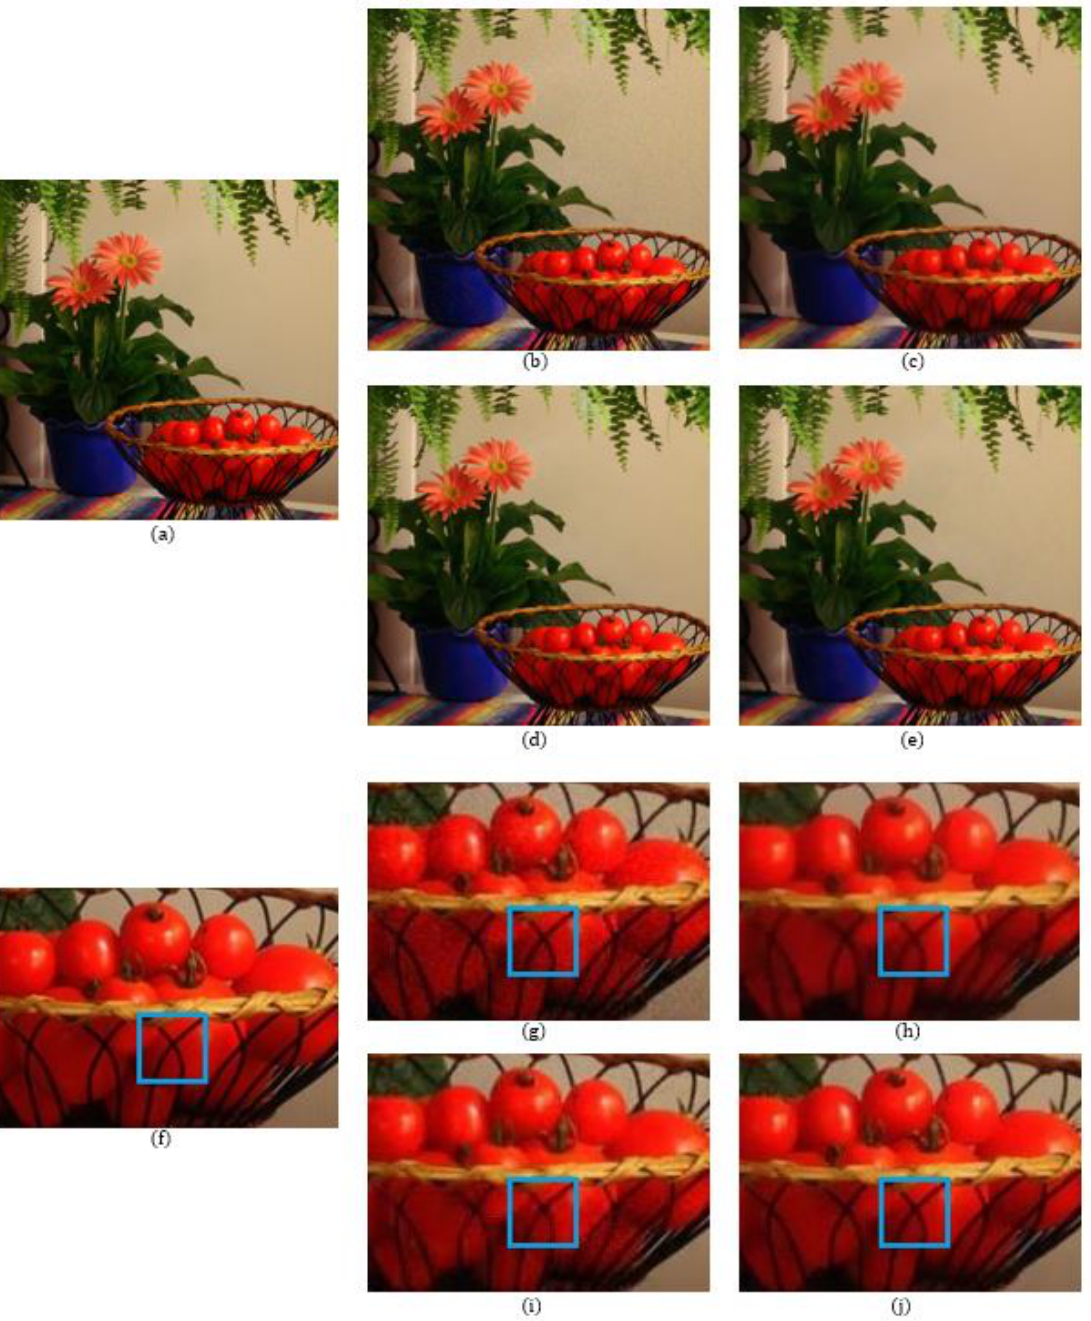
Figure 5. Comparison of the results between the different methods on MCM image 9: ( a , f ) Original; ( b , g ) residual interpolation (RI) [4] (psnr = 30.3286 dB); ( c , h ) alternating direction minimization multipliers (ADMM) [9] (psnr = 29.2356 dB); ( d , i ) block-matching and 3D filtering method (BM3D) [7] (psnr = 30.9309 dB); ( e , j ) proposed (psnr = 30.5131